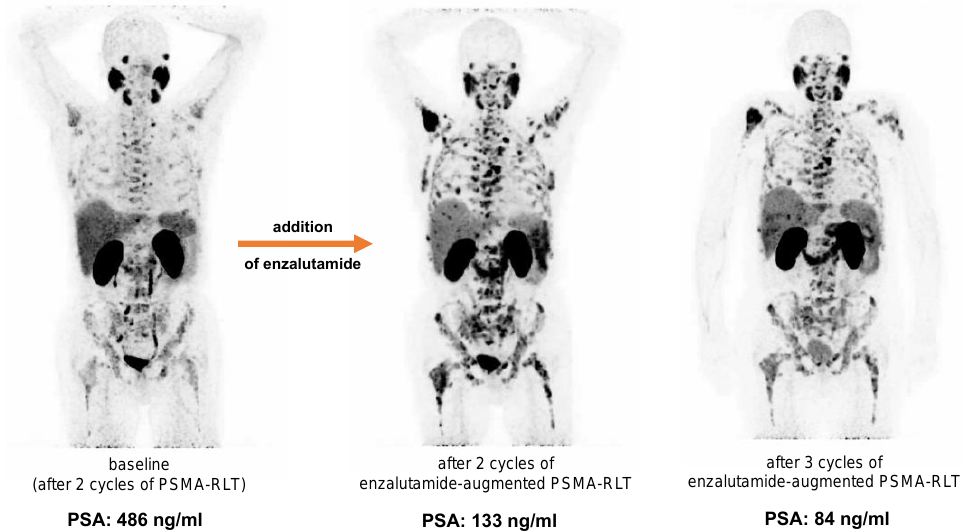
Figure 3. Example of a patient with partial remission after addition of enzalutamide to PSMA-RLT. Increased tumoral uptake after addition of enzalutamide is seen on the maximum intensity projections (MIP) of [ 68 Ga]Ga-PSMA-11 PET/CT, while PSA decreases. No serious acute adverse events were recorded after the addition of